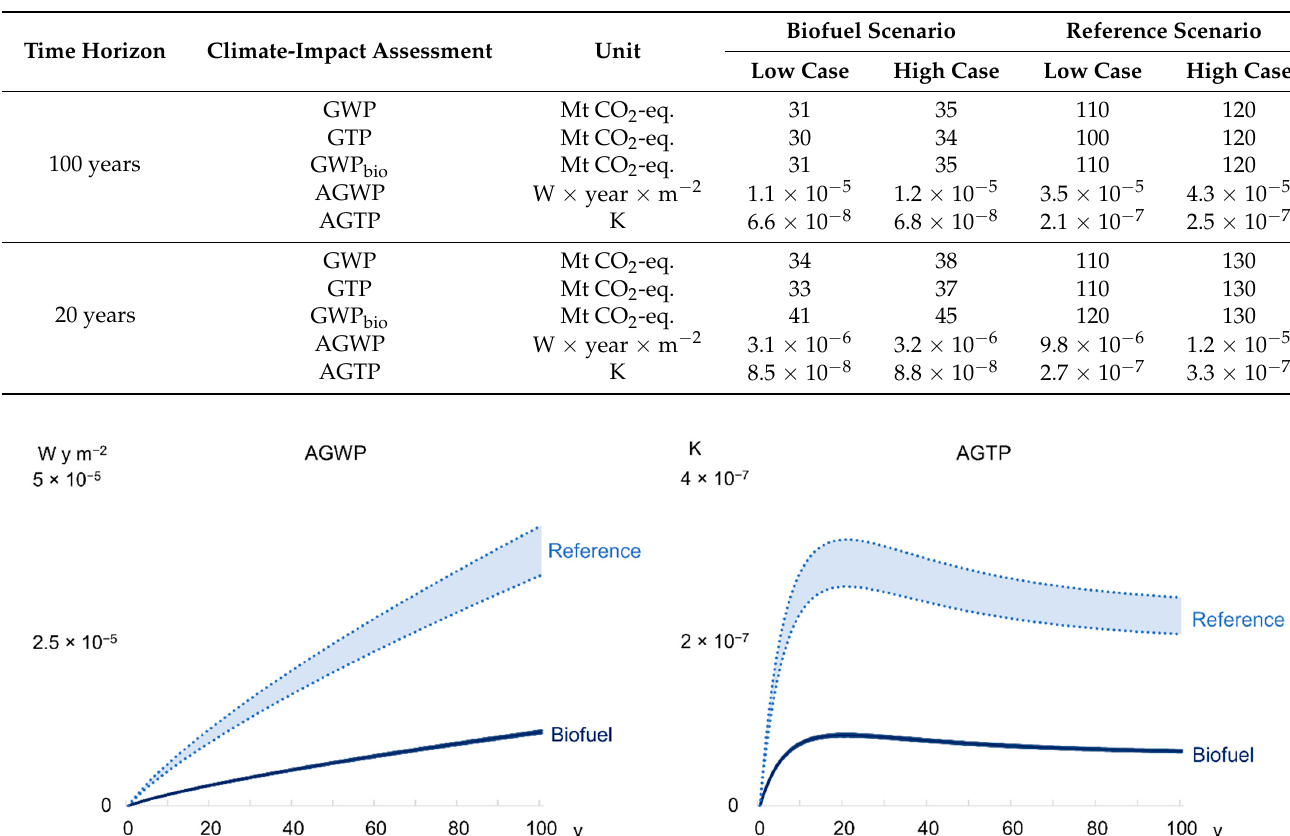
Table 4. Climate impact resulting from handling wheat straw in the biofuel scenario and the reference scenario. The climate impact is calculated for utilization of 200,000 t DM straw. Dark shading marks the scenario that results in higher climate impact.